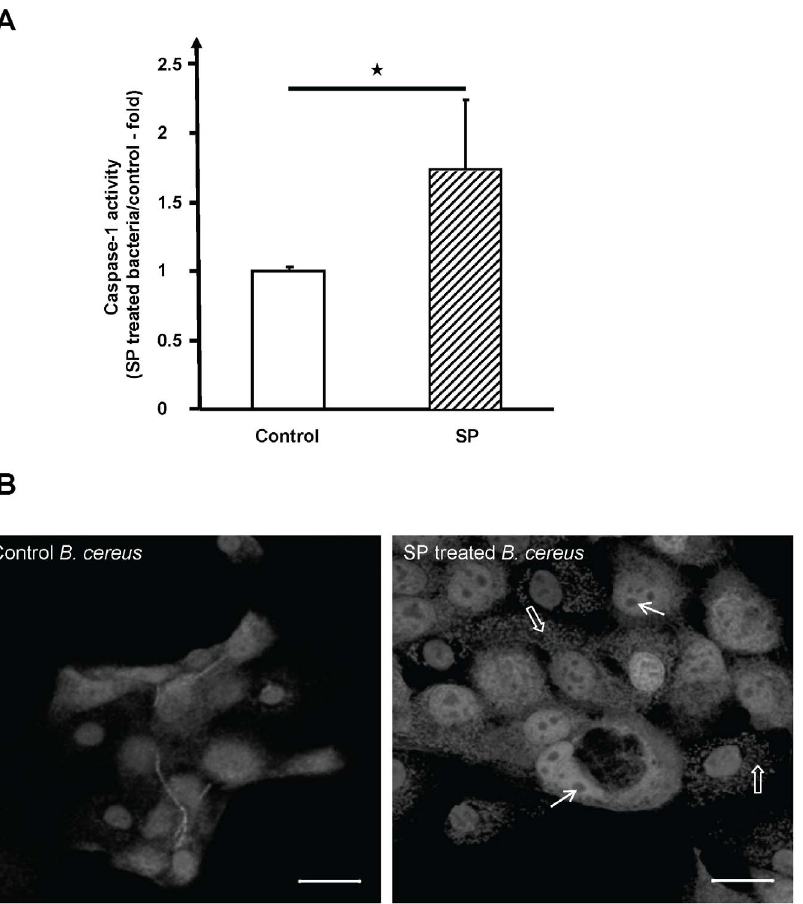
Figure 2. Effect of Substance P treated Bacilluscereus on caspase 1 induction and on the morphology of HaCaT cells. ( A ) Cells exposed to SP treated bacteria showed an increase of caspase 1 production ( w = p , 0.05 ). ( B ) After a 30 min infection with control bacteria the morphology of HaCaT cells remained unchanged but when the cells were exposed to SP treated B. cereus we observed a complete disorganization of the actin cytoskeleton ( ) and the formation of multiple cytoplasmic vacuoles ( R ). Bar=20 m